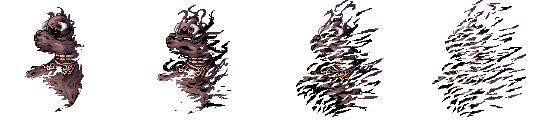
Fig. 6. Sprites where most pixels are detached from the others. Source: Ragnarok Online© game.